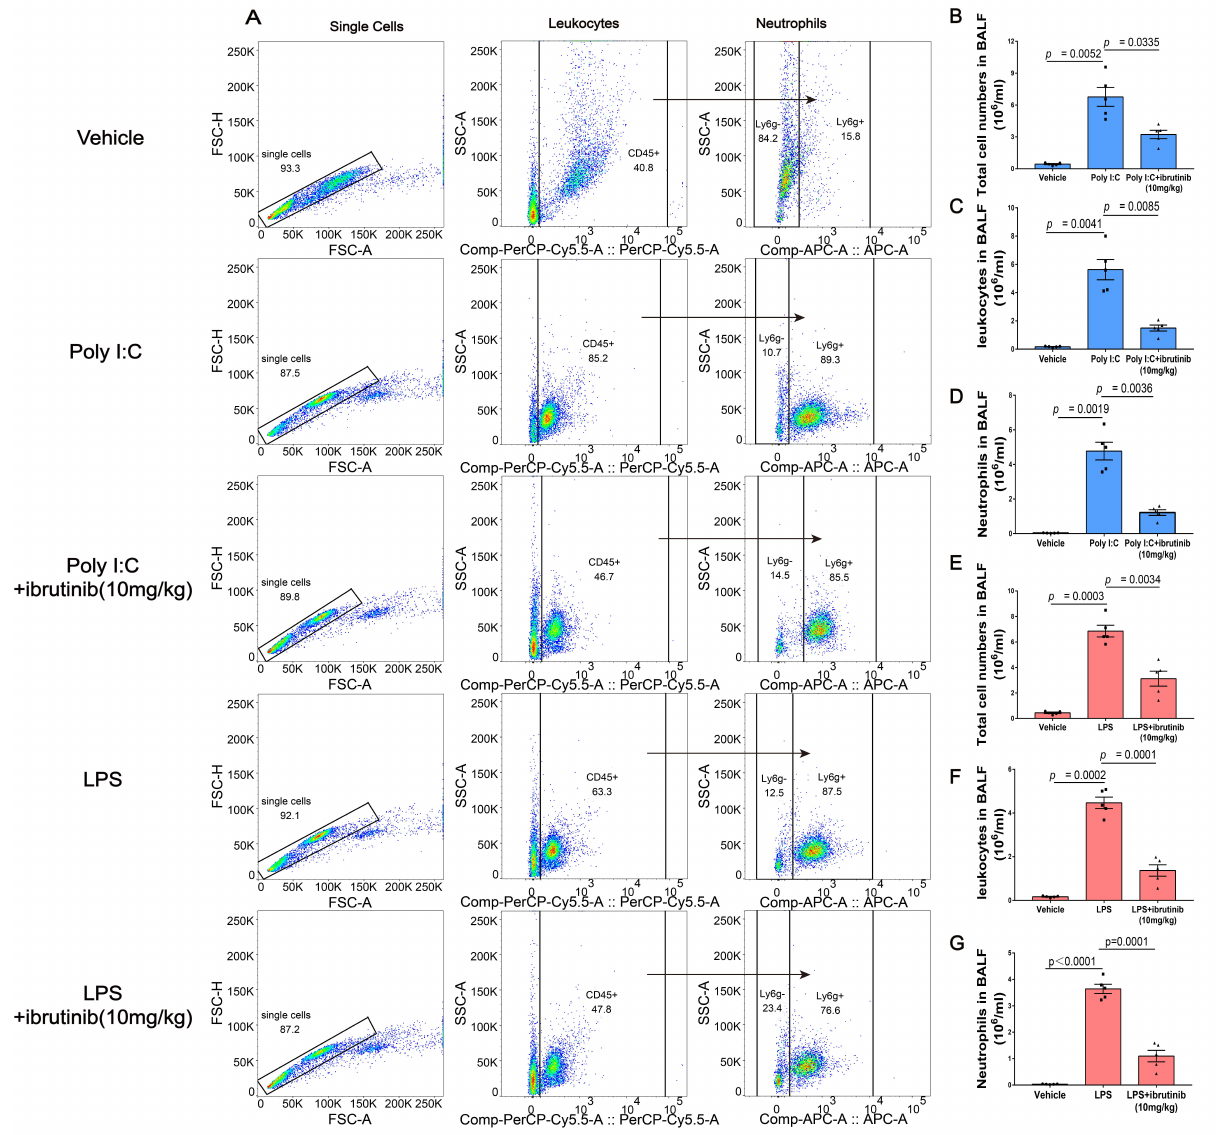
Figure 3. Effects of ibrutinib on poly I:C- and LPS-induced neutrophil infiltrations. ( A ) Flow cytometric plots showing the transmigratory neutrophils (Ly6G+/CD45+). ( B ) The numbers of total cells in the BALF at 48 h after ALI induction. ( C ) The numbers of leukocytes in the BALF at 48 h after ALI induction. ( D ) The numbers of neutrophils in the BALF at 48 h after ALI induction. ( E ) The numbers of total cells in the BALF at 24 h after ALI induction. ( F ) The numbers of leukocytes in the BALF at 24 h after ALI induction. ( G ) The numbers of neutrophils in the BALF at 24 h after ALI induction. Values are shown as means ± SEM for n =